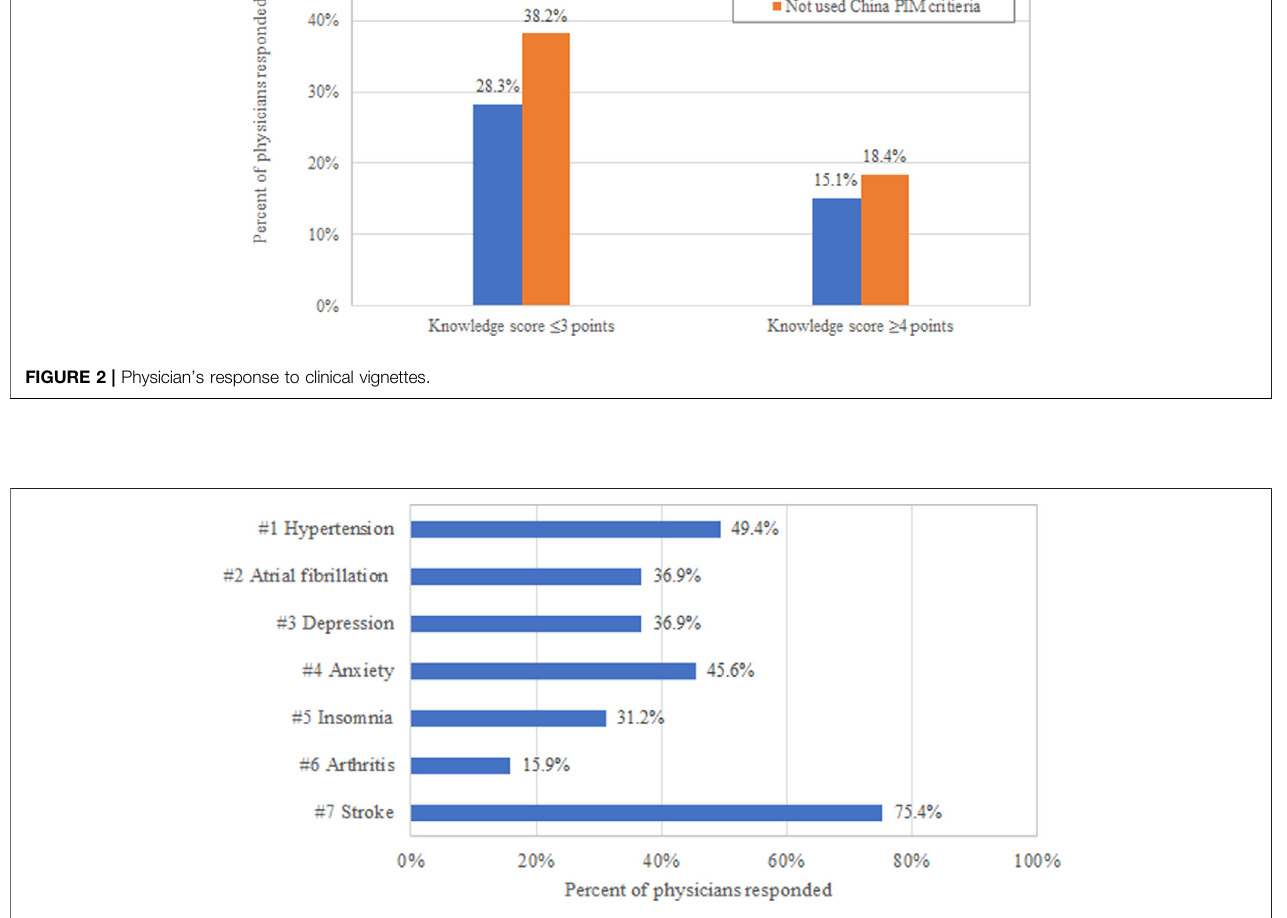
FIGURE 3 | Physicians ’ vignette-based scores by their knowledge of PIM criteria.